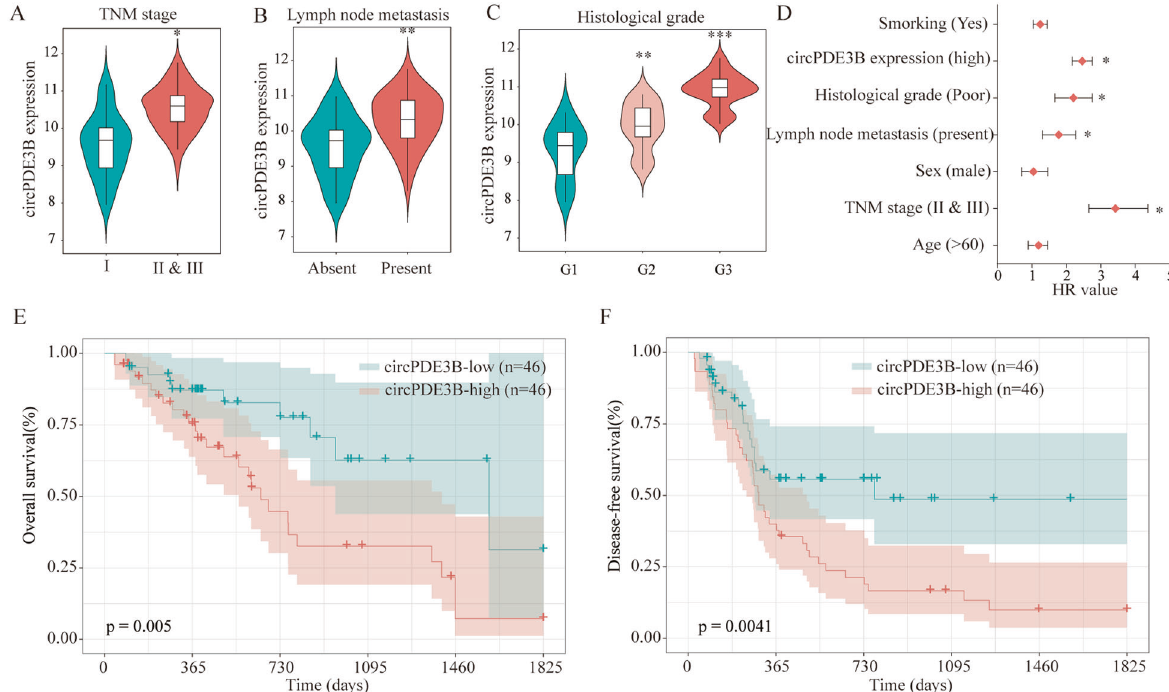
Fig. 2 Upregulated circPDE3B was positively correlated with the poor prognosis of ESCC. The correlation between circPDE3B expression lever and TNM stage ( A ), lymph node metastasis ( B ), and histological grade ( C ) of ESCC patients. D The univariate Cox proportional hazards analysis was performed to depict the correlations between the indicated clinical criteria and disease-free survival rate. Patients with higher circPDE3B expression had a shorter overall survival time ( E ) and disease-free survival time ( F ) than those with lower circ-circPDE3B expression. * p < 0.05, ** p < 0.01, *** p <